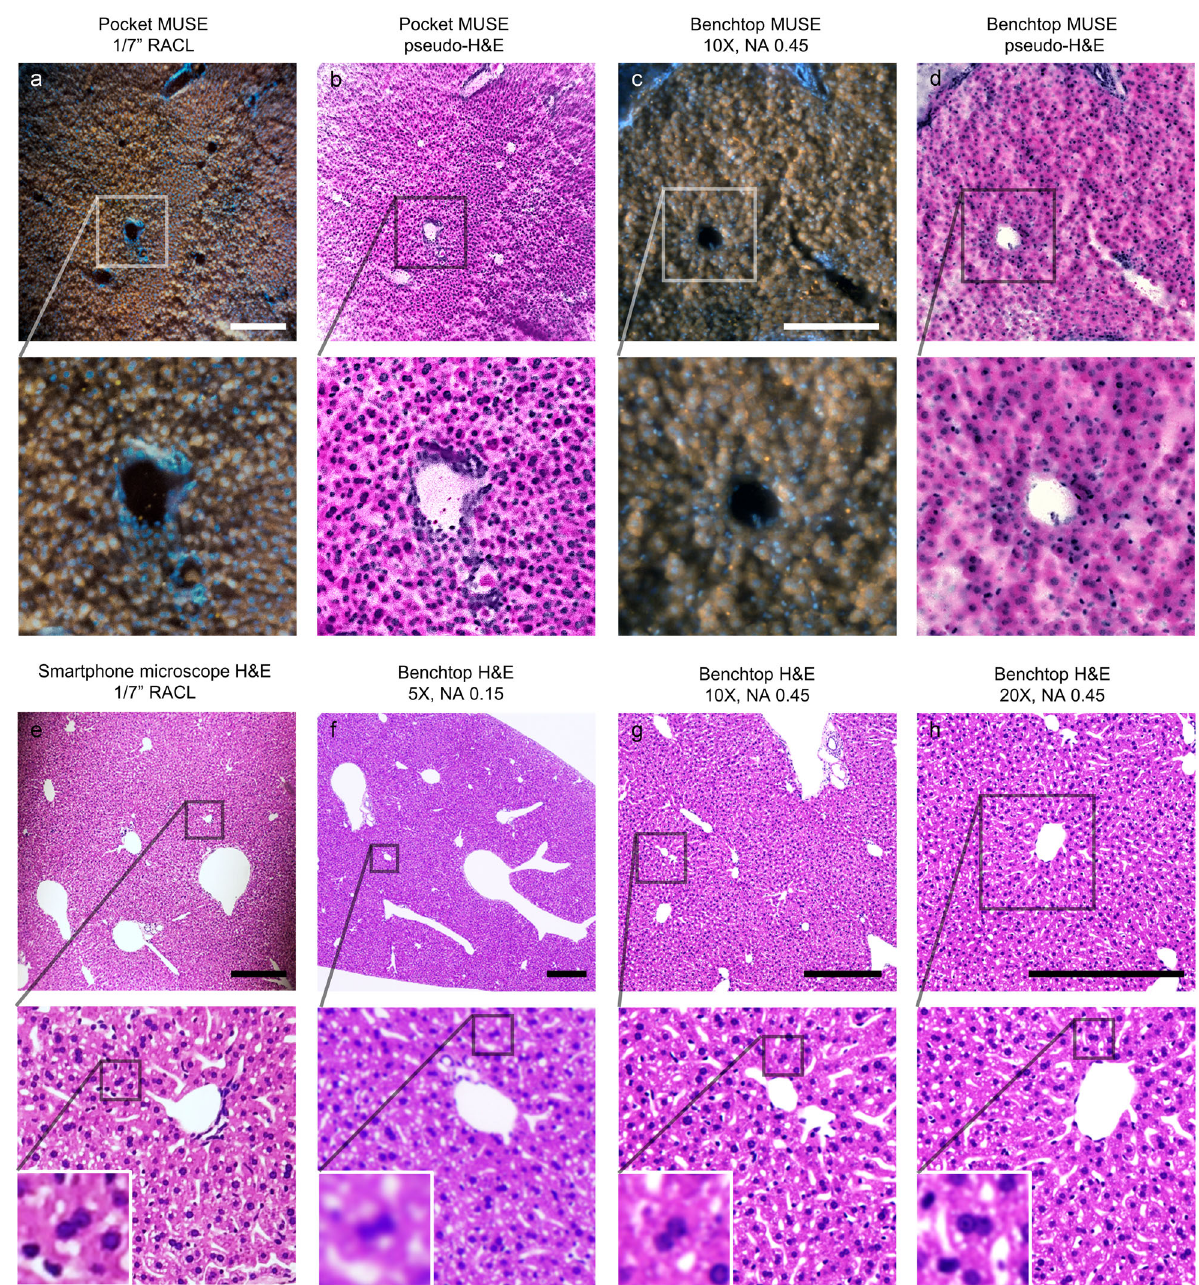
Fig. 2 Images from Pocket MUSE and other imaging modalities. a Pocket MUSE image of a thick mouse liver section stained with 0.05% w/v Rhodamine B and 0.01% w/v DAPI. b Psuedo-H&E color-remapping of ( a ). c Benchtop MUSE image of the same sample from ( a ). d Psuedo-H&E colo-remapping of ( c ). Close-up views of the region in the boxes (box size: 300 × 300 µ m 2 ) are shown below. e Smartphone microscopy image of a mouse liver H&E slide using the same RACL from Pocket MUSE. f – h The same H&E liver slide imaged with a benchtop microscope at 5×,10×, and 20× magni fi cations. 2-level close-up views of the images are shown below for ( e ) – ( h ) (Box sizes: 250 × 250 µ m 2 for level 1 and 30 × 30 µ m 2 for level 2). The contrast between imaging modalities is different (e.g., nucleoli have less contrast in the MUSE images). Scale bars: 300 µ